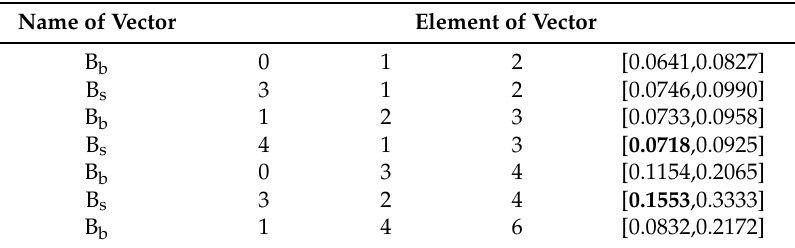
Table 10. Identification template 3 for water class. Table 3. Identification template 1 for cropland